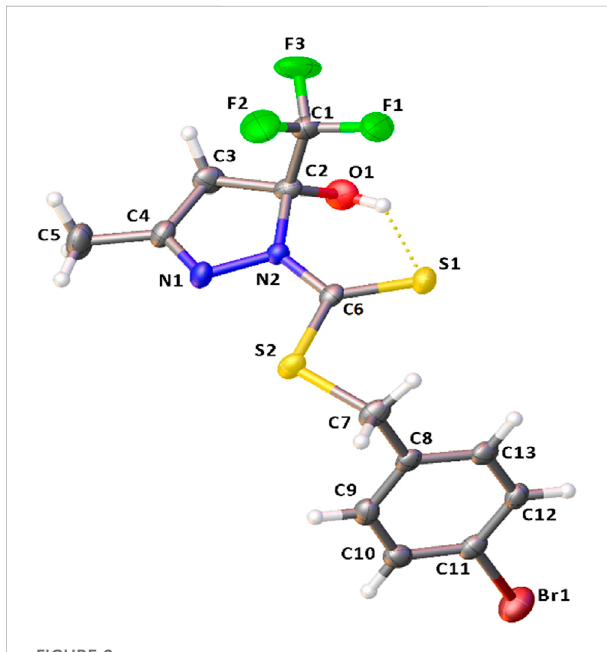
FIGURE 2 Molecular structure of H 2 L 1 with crystallographic labeling (30% probabilitydisplacement).Theintramolecularinteractionisshownasa dashed